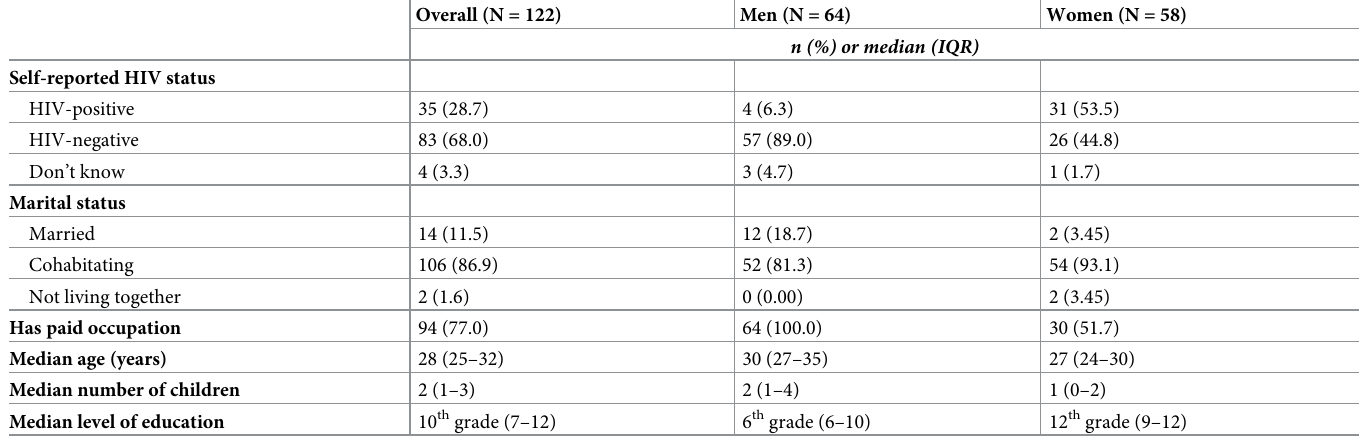
Table 1. Participant